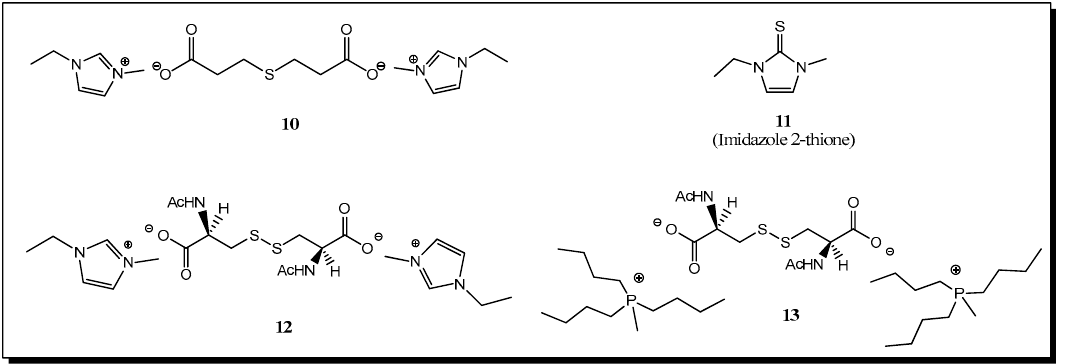
Figure 1. Compounds isolated for imidazolium ILs 2 , 3 and 6 after heating.